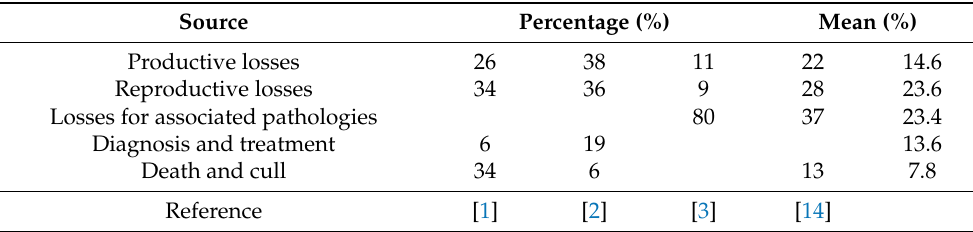
Table 2. Percentage (%) of contribution from different sources of losses to the final cost of a case of